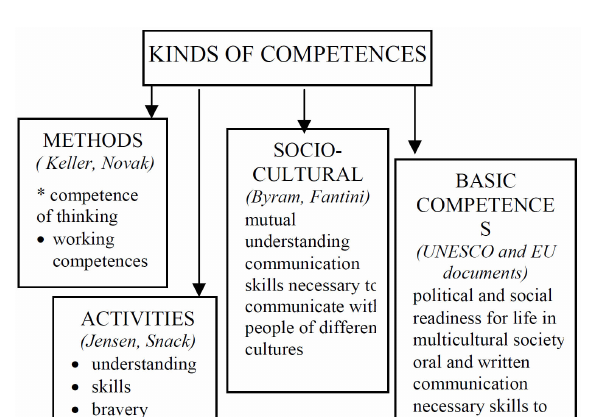
Figure 2. Kinds of Competences -3